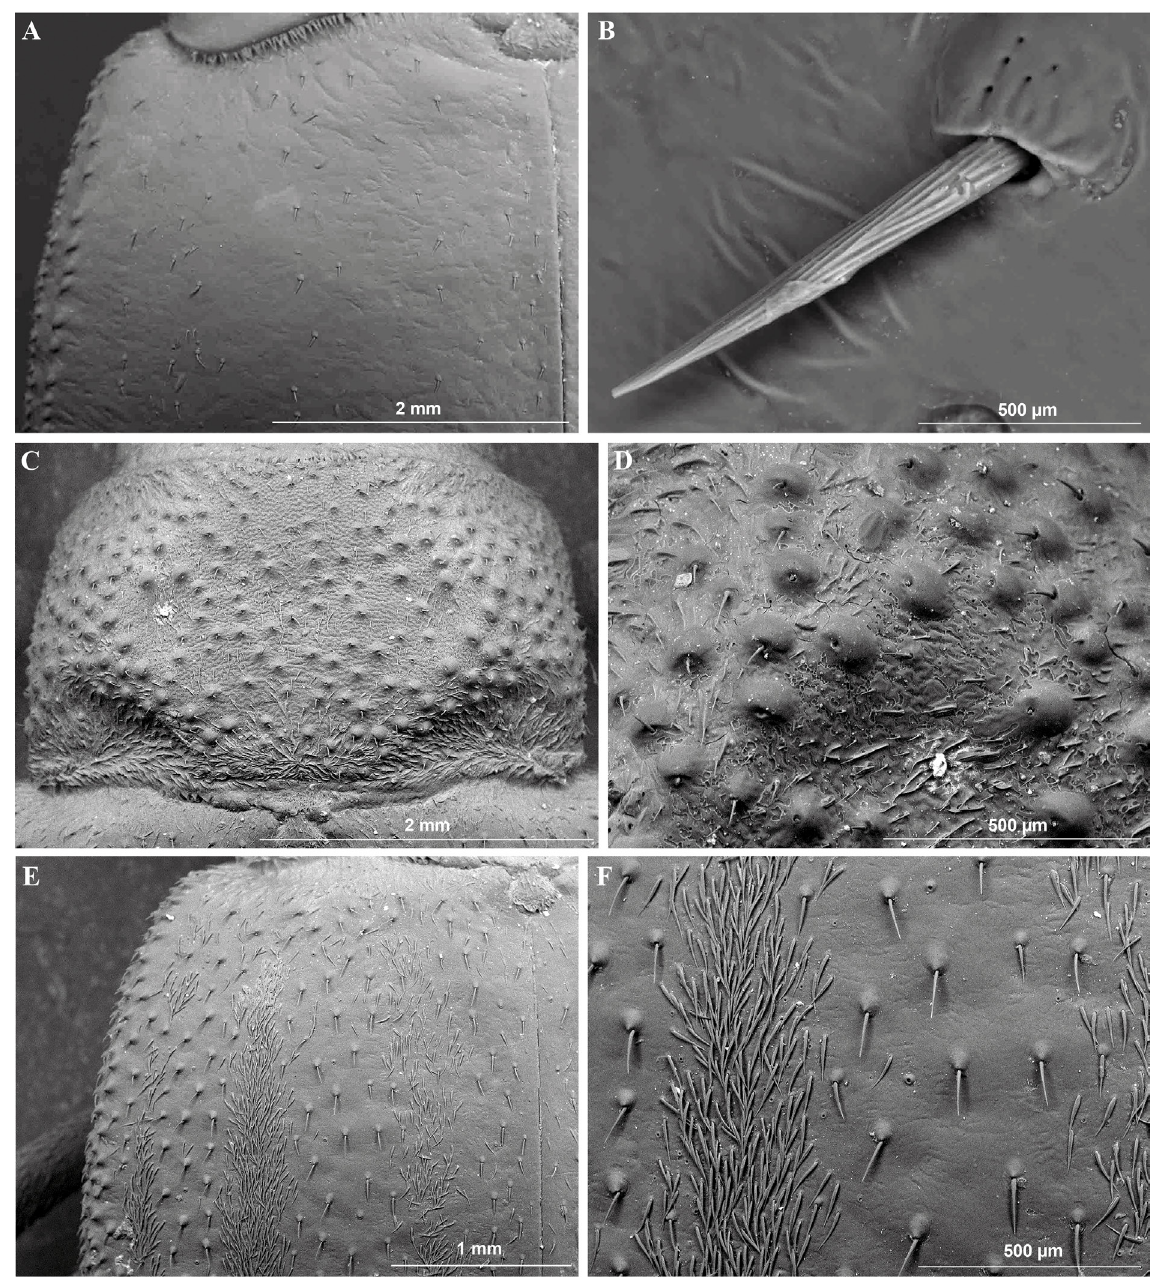
Fig. 12. Mantichorula Reitter, 1889 and Platyope Fischer von Waldheim, 1820, details of structure. A . M. semenowi Reitter, 1889, ♂ (ZIN), base of left elytron. B . Ditto, pubescence of elytron. C . P. leucogramma (Pallas, 1773), ♂ (ZIN), pronotum. D . Ditto, hemispherical tubercles and pubescence of pronotum. E . Ditto, basal half of left elytron. F . Ditto, pubescence of